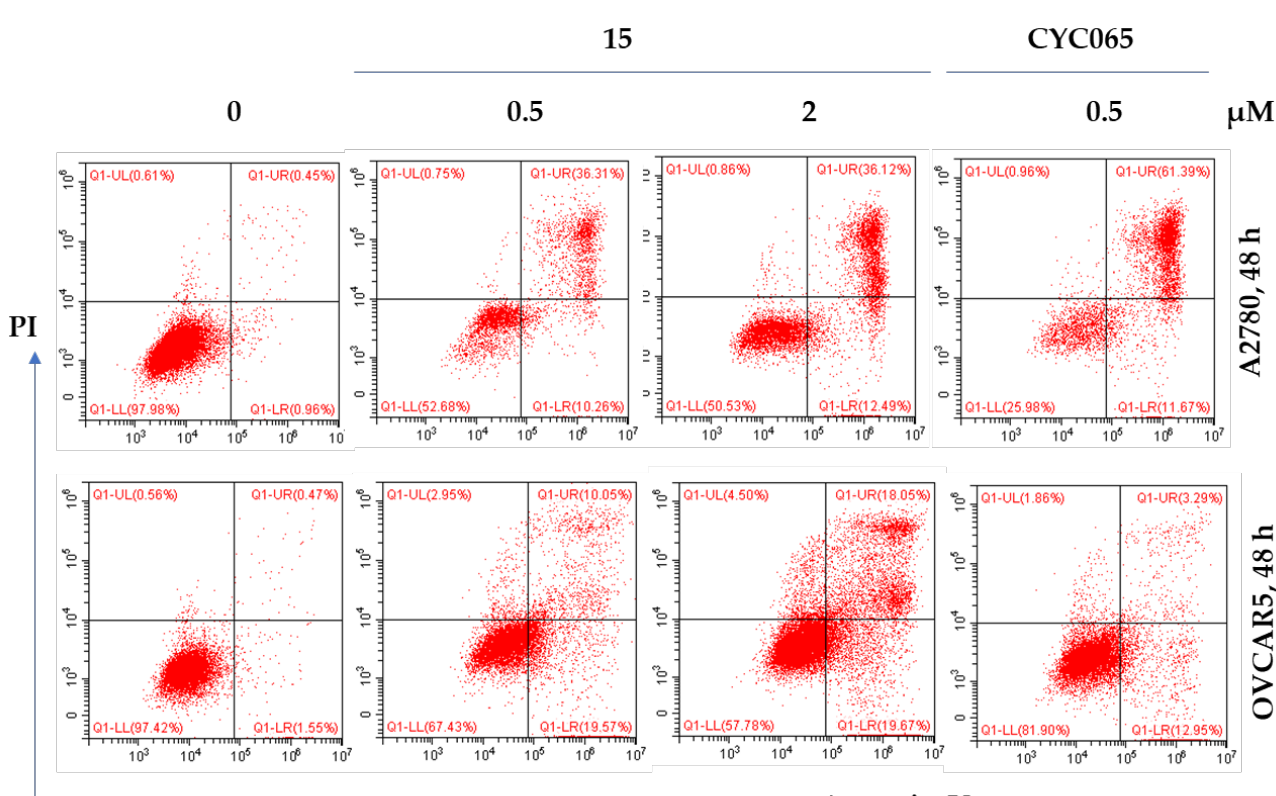
Figure 5. Effect of 15 on apoptosis in A2780 and OVCAR5 cells. Cells were incubated with 15 at 0.5 or 2 µM or CYC065 at 0.5 µM for 48 h. DMSO diluent was employed as a control. Apoptosis was determined by annexin V/PI staining. Experiments were performed twice, and representative data are presented. Viable cells are shown in the lower left quadrant, and they were not stained by either staining reagent, whereas the early apoptotic cells in the lower right quadrant were stained by an- nexin V. The late apoptotic cells in the upper right quadrant were stained by both staining reagents, while the necrotic cells in the upper left quadrant were stained by PI. The sum of the percentages of cells undergoing early (annexin V positive/PI negative) and late apoptosis (annexin V positive/PI positive) is taken as the total percentage of the apoptotic cells.